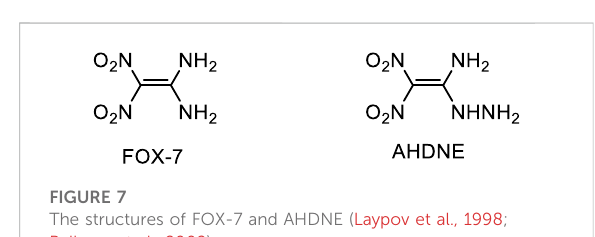
FIGURE 7 The structures of FOX-7 and AHDNE (Laypov et al., 1998; Ballamy et al.,